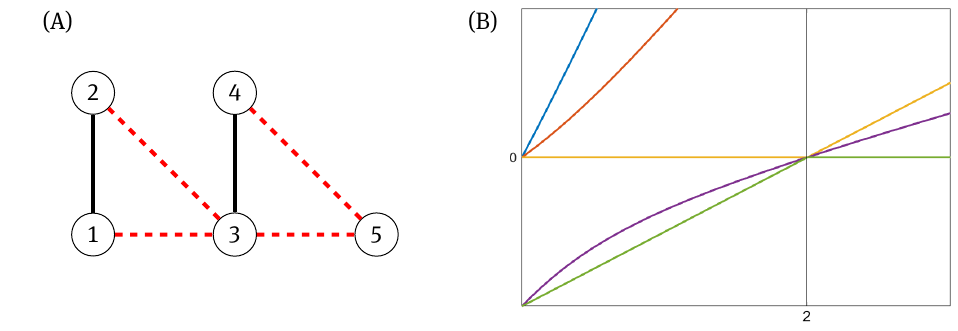
Figure 3: (A) Signed graph G · G where G = K 3 with one positive edge and two negative edges. (B) A 2 -crossing of a consistent weighting of G · G with weights ±1 .